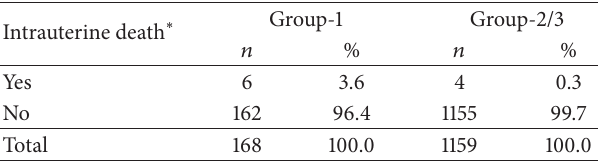
Table 2: Distribution of occurrence of intrauterine death between Group 1 and Groups 2-3 (Group-1: SGA according only to Bangladeshi growth chart; Group-2: SGA according to European growchartandAGAaccordingtoBangladeshigrowthchart;Group- 3: AGA according to both growth